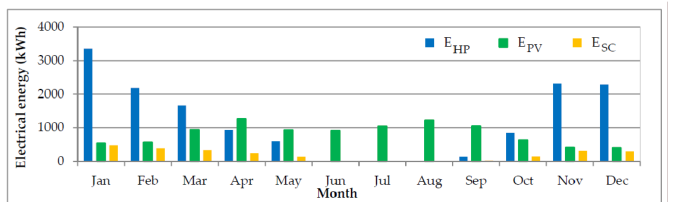
Figure 13. The monthly simulated electrical energy consumption of the geothermal heat pump (E HP ), electrical energy output of the photovoltaic platform (E PV ) and the electrical energy output of the photovoltaic platform directly consumed by the geothermal heat pump (E SC ).